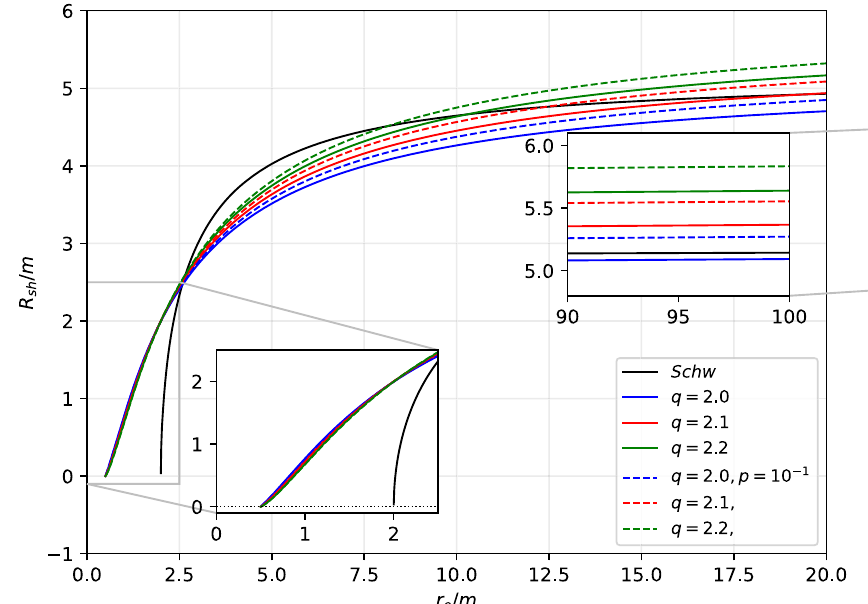
Fig. 2 Plot of the shadow radius of the wormhole at varying locations of a static observer. Here, we compared the shadow behavior between the Schwarzschild case, and the wormhole with and without the influence of plasma. We set m = 1 and the plasma parameter p = 10 −